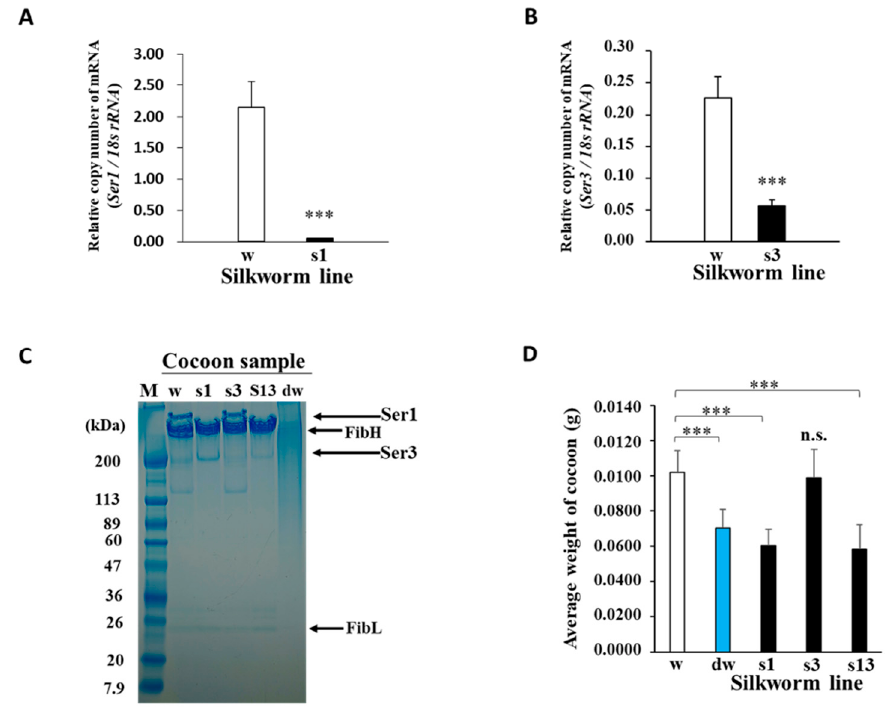
Figure 2. Functional effects of P1A269 expression in middle silk glands (MSGs). ( A , B ) Quantitative RT-PCR analysis of the relative Ser1 (s1) and Ser3 (s3) mRNA levels in the Ser1-P1A269 and Ser3-P1A269 lines, respectively. Total RNAs were isolated from the MSGs of the respective larvae. The mRNA levels of Ser1 at day 5 of the fifth instar of the Ser1-P1A269 line and Ser3 at day 6 of the fifth instar of the Ser3-P1A269 line were quantified and compared with that of w1-pnd (w) at the same developmental stage, respectively. The expression levels of Ser1 and Ser3 mRNAs were normalized to that of 18S ribosomal RNA. Data are presented as the means ± SD of relative values (copy number); n = five (for Ser1 mRNA) and n = eight (for Ser3 mRNA) independent samples; *** p < 0.001 versus w1-pnd (Student’s t -test). ( C ) SDS–PAGE analysis of the cocoons produced by w1-pnd (lane w), the Ser1-P1A269 line (lane s1), Ser3-P1A269 (lane s3), Ser1/3-P1A269 (lane s13), and degummed w1-pnd (lane dw). The cocoons were dissolved in concentrated LiBr solution, diluted in water, and electrophoresed on a 5–20% gradient gel, along with the protein marker (lane M). Arrows on the right indicate the positions of FibH, FibL, Ser1, and Ser3 [4,5]. ( D ) Comparison of the cocoon weights. The dry weight of w1-pnd (w), degummed w1-pnd (dw), the Ser1-P1A269 line (s1), Ser3-P1A269 (s3), and Ser1/3-P1A269 (s13) cocoons were measured. Data are presented as the means ± SD; n = 50 independent samples. *** p < 0.001 (one-way ANOVA, followed by Tukey’s test); n.s., not significant versus w1-pnd